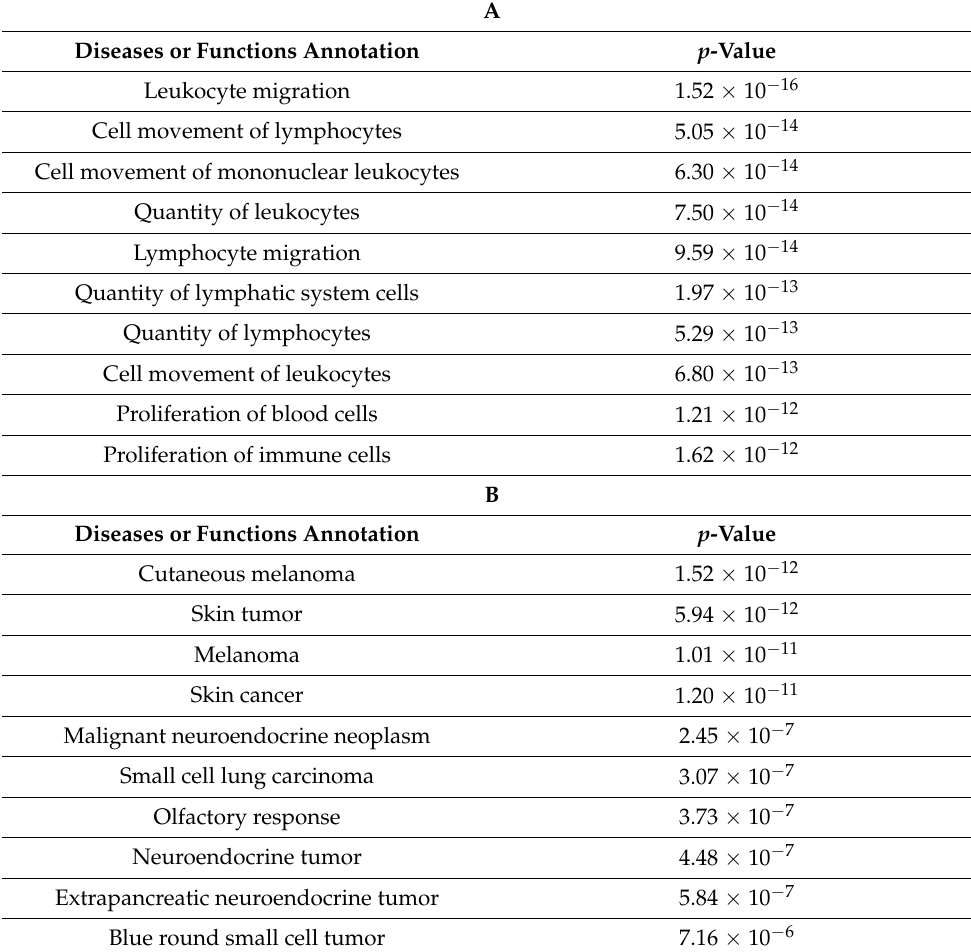
Table 2. Diseases or Functions Annotation from IPA Core Analysis on given gene datasets. The top 10 most significant annotations are